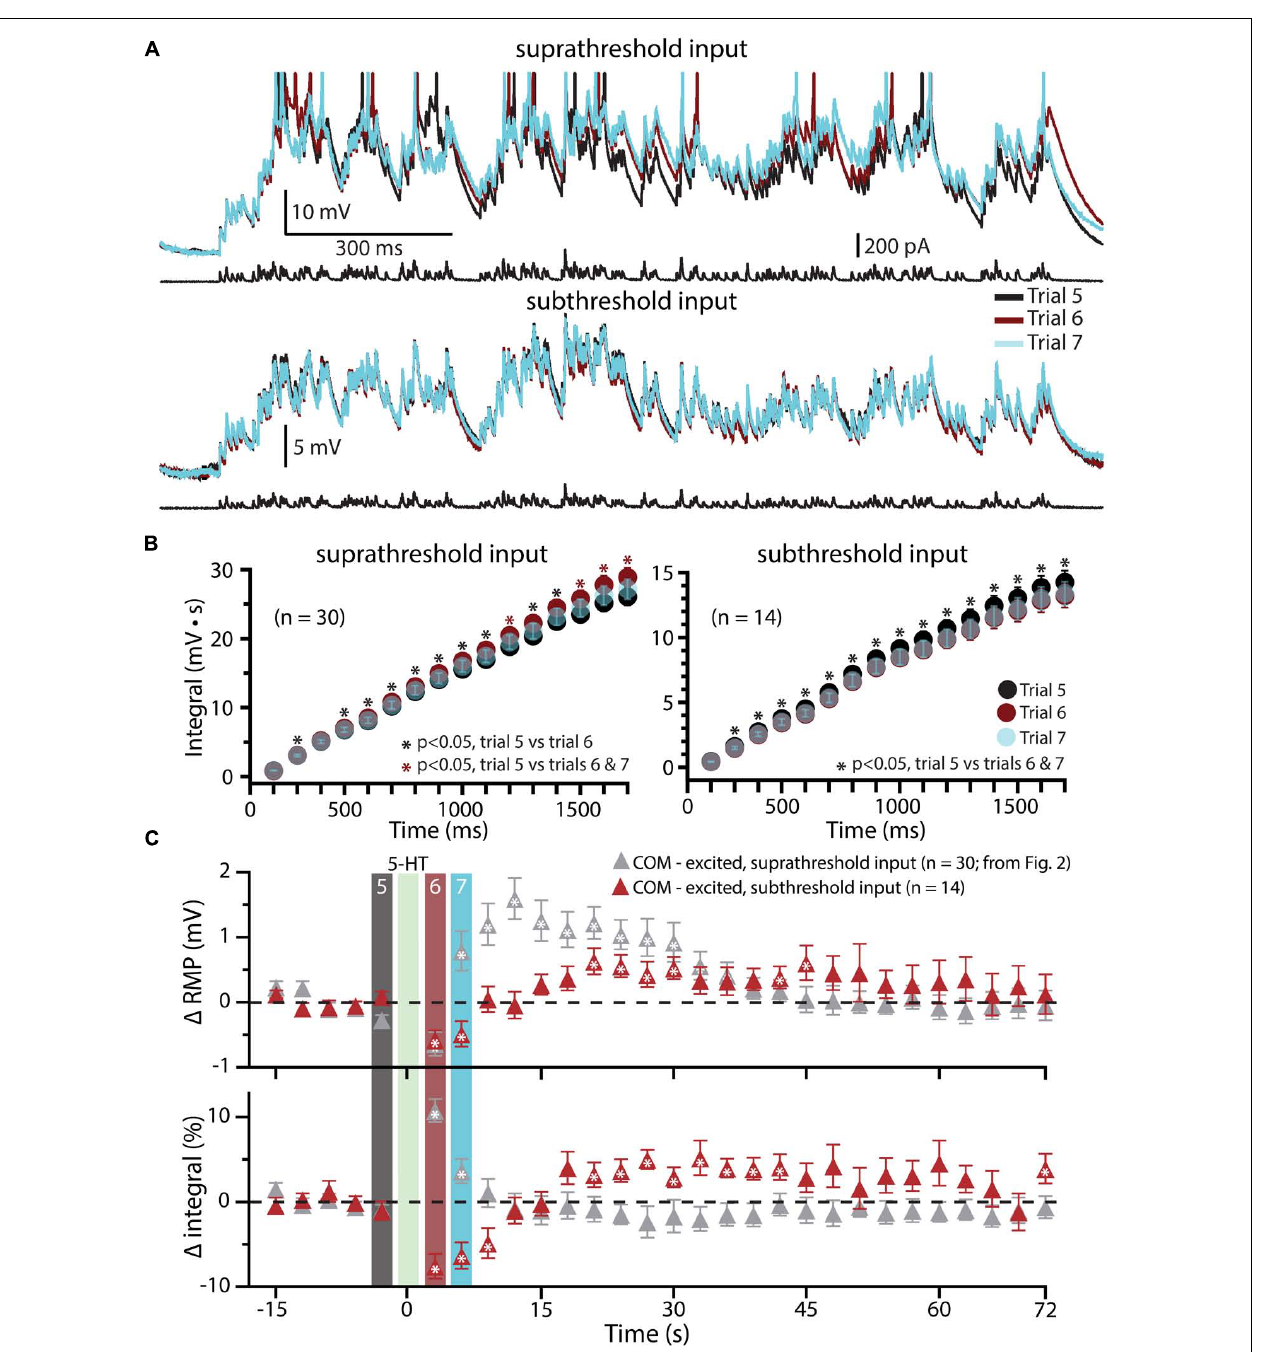
FIGURE 5 | Subthreshold simulated synaptic input does not facilitate serotonergic responses in COM-excited L5PNs. (A) Responses of a COM-excited L5PN experiencing suprathreshold simulated synaptic input (top; action potentials truncated) or subthreshold simulated synaptic input (bottom). Baseline responses (trial 5, black) are superimposed with responses immediately after 5-HT application (trial 6, red), or 3 s later (trial 7, blue), as indicated in panel C . For subthreshold trials, current intensities were scaled to 80% of the minimum current necessary to elicit a single spike. (B) Plots of cumulative response integrals (binned at